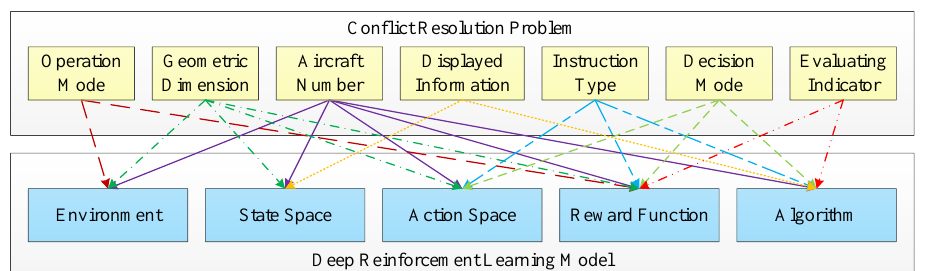
Figure 17. Relationship between conflict resolution and DRL